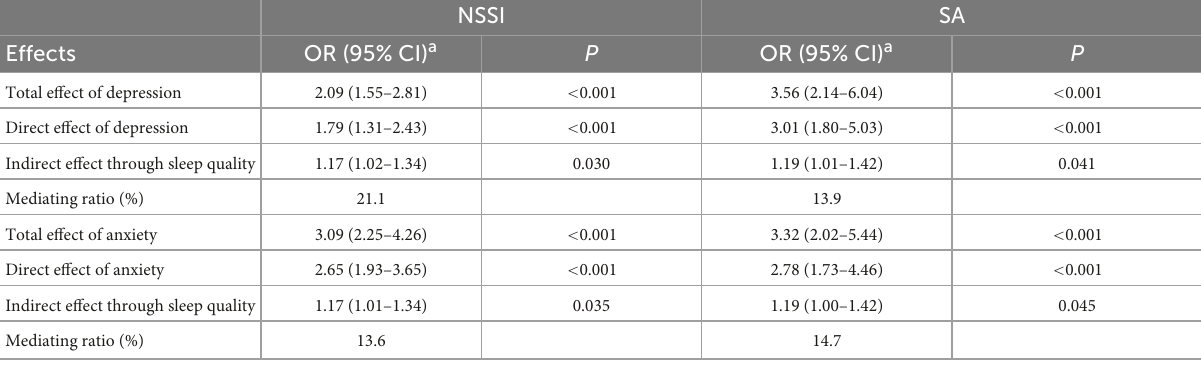
TABLE 4 Logistic regression model of direct and indirect effects through sleep quality of depressive and anxiety symptoms on NSSI and SA. NSSI